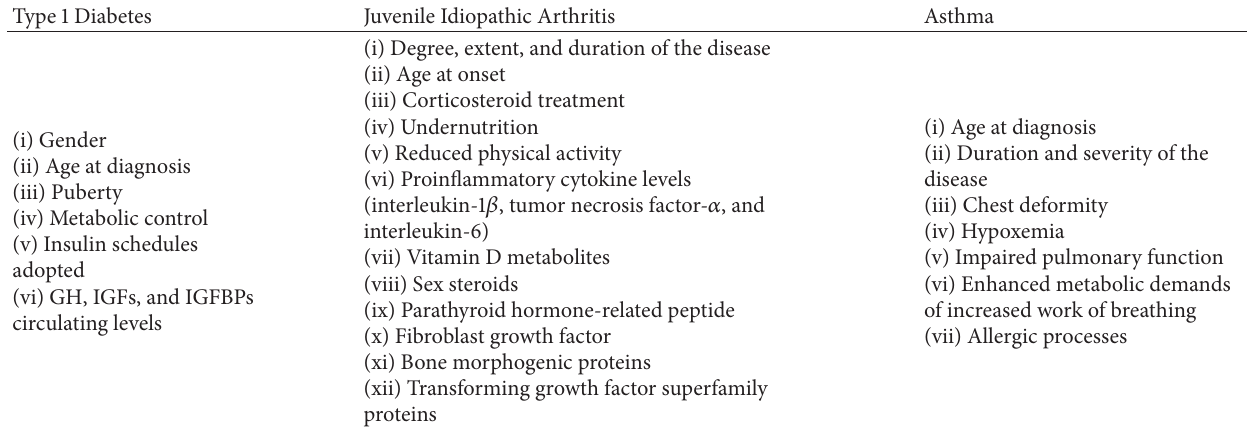
Table 1: Main factors associated with the development and progression of bone alterations in children and adolescents with type 1 diabetes, juvenile idiopathic arthritis, and